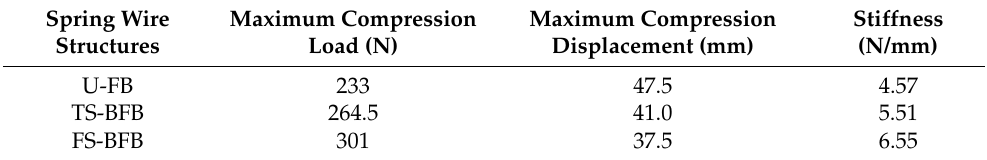
Figure 5. ( a ) The load-displacement curve during the static stiffness test; ( b ) the flat curves for the cycling test; ( c ) spring stiffness; and ( d ) compression load. Table 2. Comparison of compression properties of an HCS with different spring wire structures.